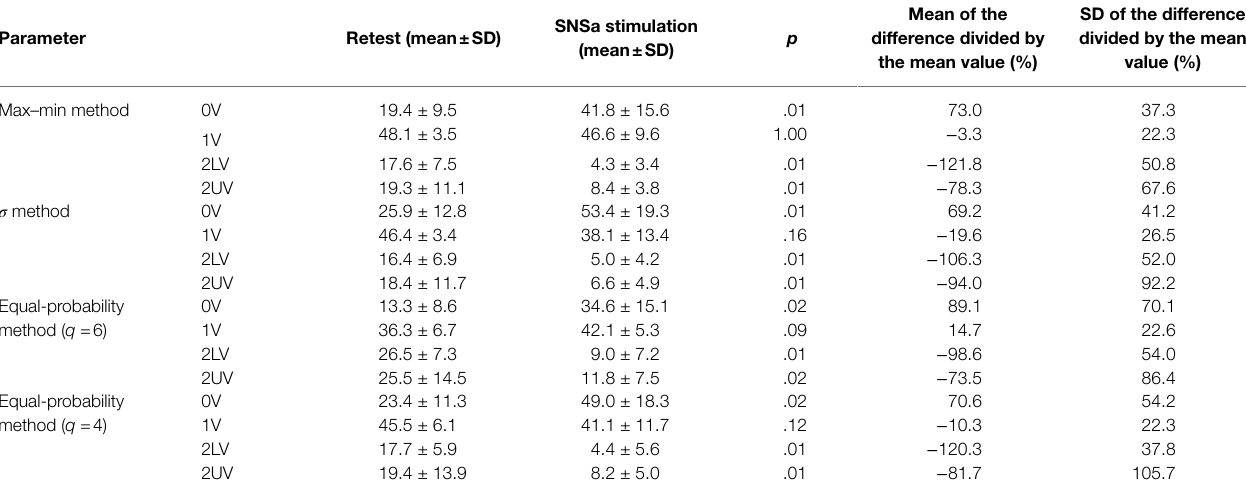
TABLE 3 | Results of the comparison between Retest and SNSa stimulation in analyzed symbolic dynamics indices.